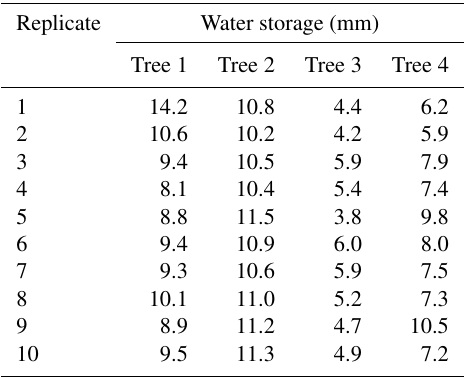
Table 1. Water storage capacity of the leaf axils along the trunks of oil palm trees.